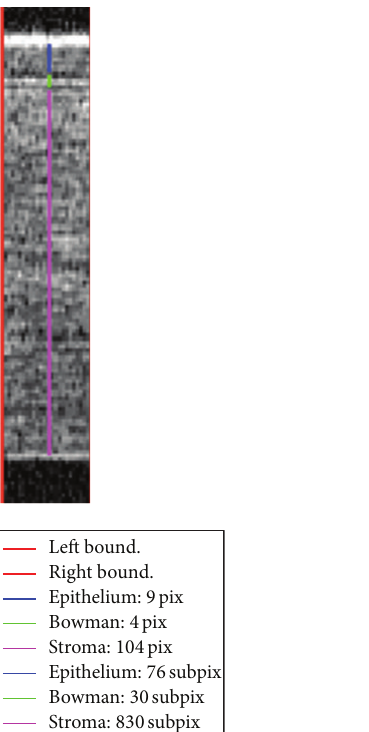
Figure 6: Detail of the central ROI slice. In the box, thickness estimates are reported both in pixel and subpixel scale.